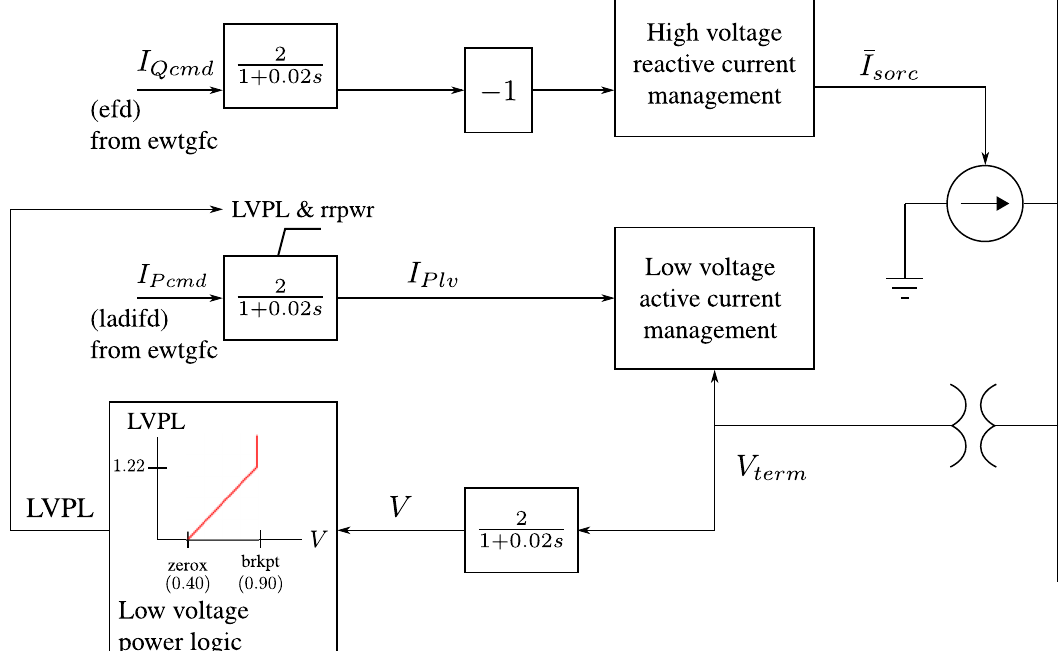
Figure 2. First-generation PV model: generator